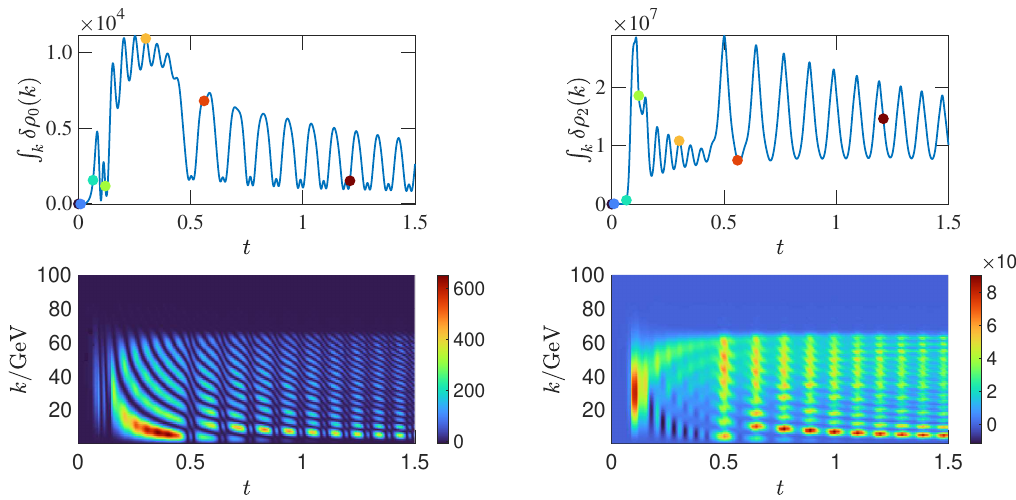
Figure 7 . The upper panels: shown are the integrated non-equilibrium fluctuations of the moment functions, R δρ 0 , 2 k . The colored dots have the same interpretation as in figure 6. The lower panels: k heat plots showing the momentum distributions 1 k 2 δρ n k corresponding to the upper panels. The 2 (cid:25) 2 left panels show the zeroth moment n = 0 and the right panels the second moment n = 2